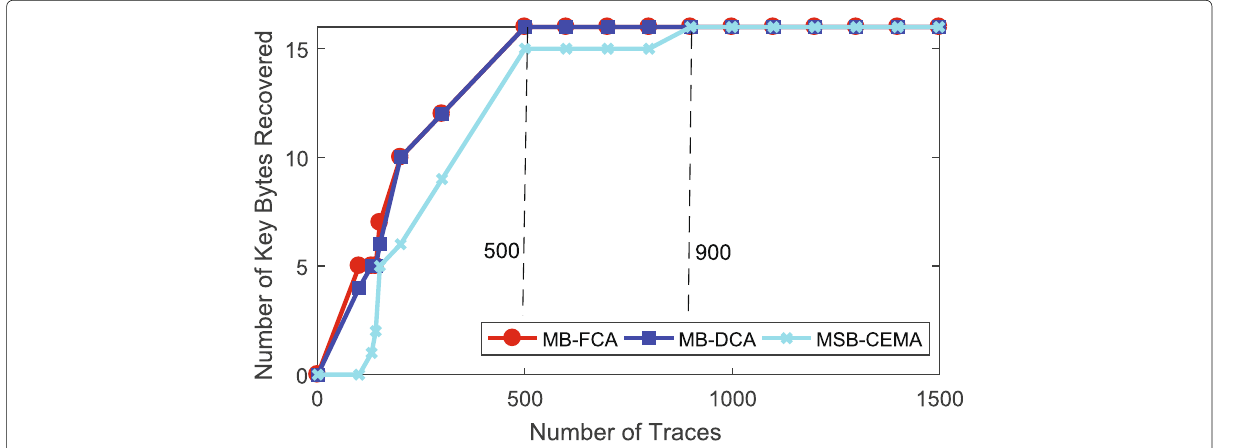
Fig. 7 Experimental results of MB-FCA, MB-DCA and MSB-CEMA, where MSB-CEMA denotes the single-bit CEMA with the